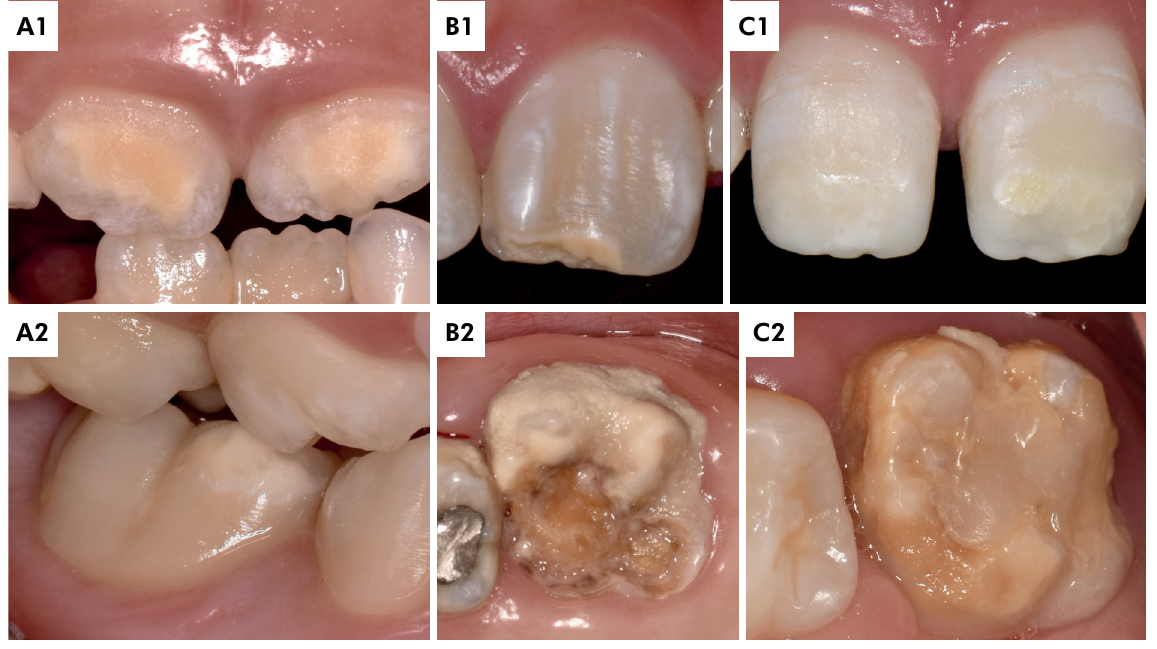
Figure 2. Clinical appearance of Molar-Incisor Hypomineralization. Demarcated opacities on buccal surface represent mild defects in permanent incisors (A1) and first permanent molars (A2); structural loss associated with opacities in incisors (B1) and a molar (B2); atypical restoration of permanent incisors (C1) and first permanent molars (C2). Figures B and C depict severe defects. The photos are courtesy of Dr. Restrepo (Universidad